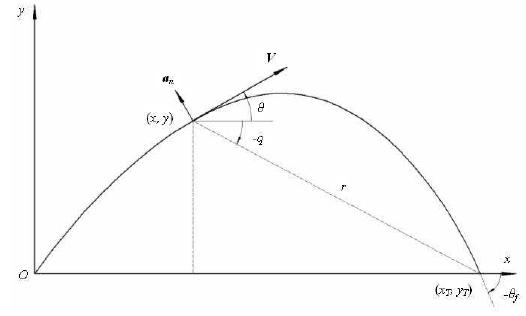
Fig. 1. Missile’s flight path in the pitch